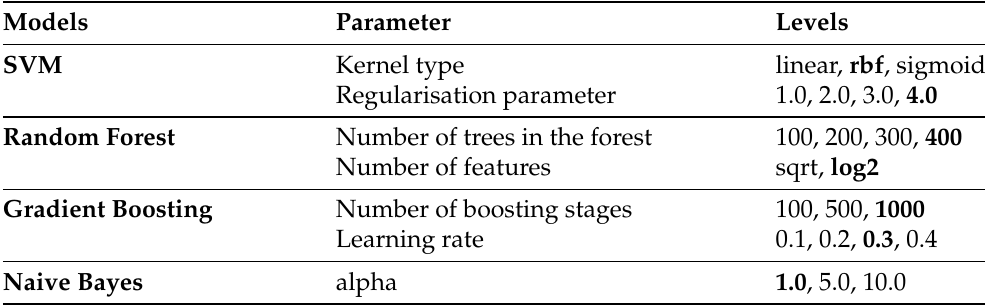
Table 6. Grid search parameters and levels for machine learning models when using raw text of the messages (Experiment 2).